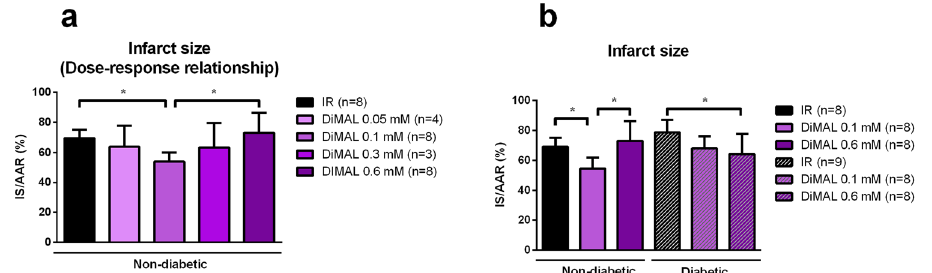
Figure 3. Isolated rat heart study – Dose-response relationship and infarct size. Dose-response relationship showing the effect of DiMAL on infarct size (IS) as a percentage of area at risk (AAR) in non-diabetic rat hearts ( a ) and IS/AAR of different intervention groups in non-diabetic and diabetic ZDF rat hearts ( b ). IR: Ischemia reperfusion, DiMAL: Dimethyl Malonate. Data are the mean ± SD. * P < 0.05 between indicated